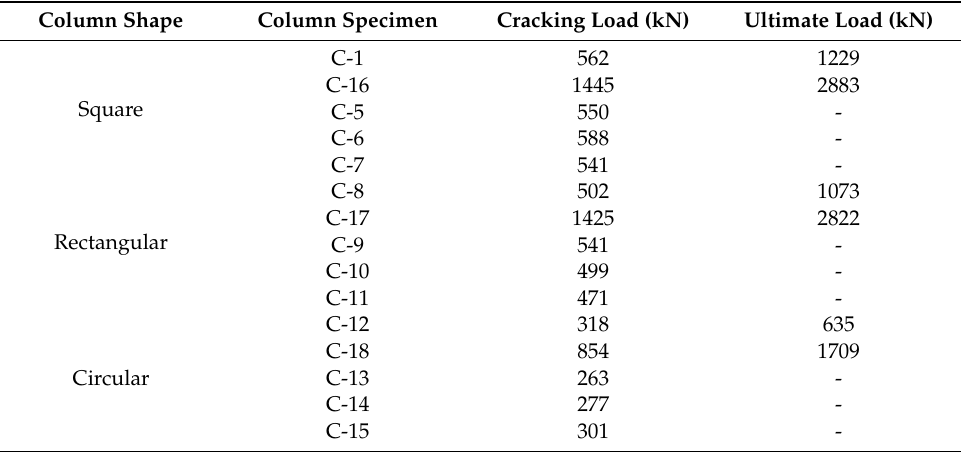
Table 3. Summary of the experimental test